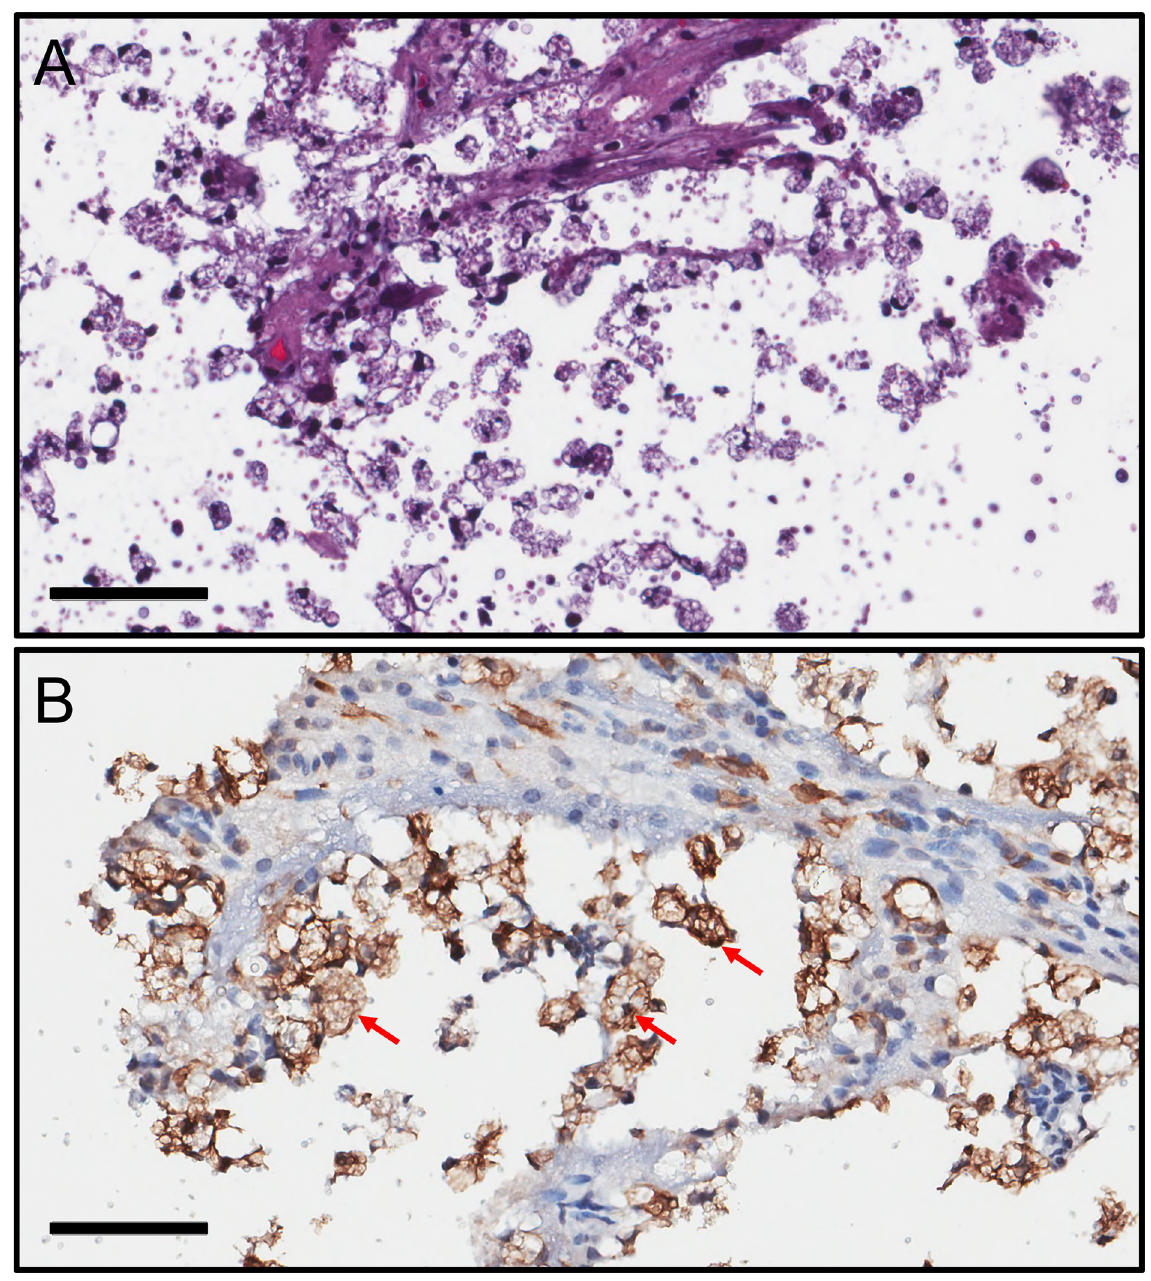
Fig 12. Activated microglia inside of a cryptococcoma fighting the infection in the striatum. (A) H&E straining demonstrating phagocytic cells engulfing fungal cells and necrotic tissue in the cryptococcoma. (B) IHC for Iba-1 in the cryptococcal lesion shows microglia or hueco cells with vacuolated cytoplasm (red arrows) responding to the progressive encephalomalacia. For A and B , scale bar: 60 μ m.